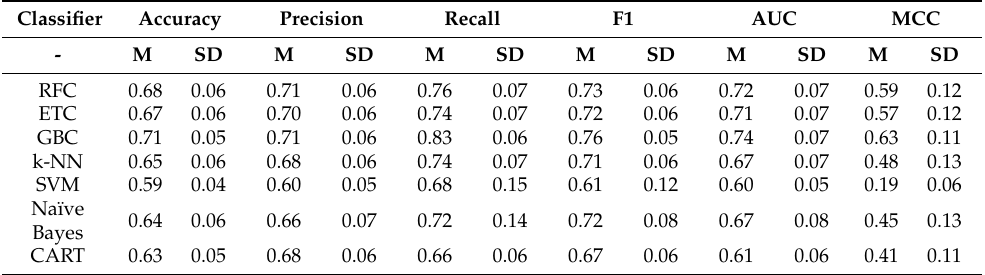
Table 3. Results of ML classifiers for the CA problem. Average of target